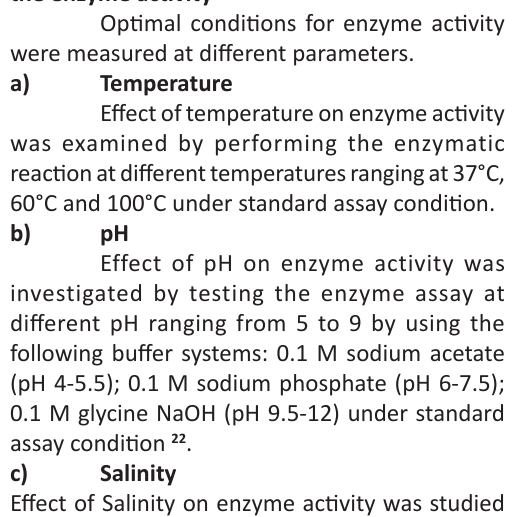
Table 1. Primary enzymatic screening of different extracellular enzymes produced from different Actinomycetes and Eubacteria isolates. Total Caseinase Amylase Esterase Cellulase L-asparaginase Actinomycetes 26